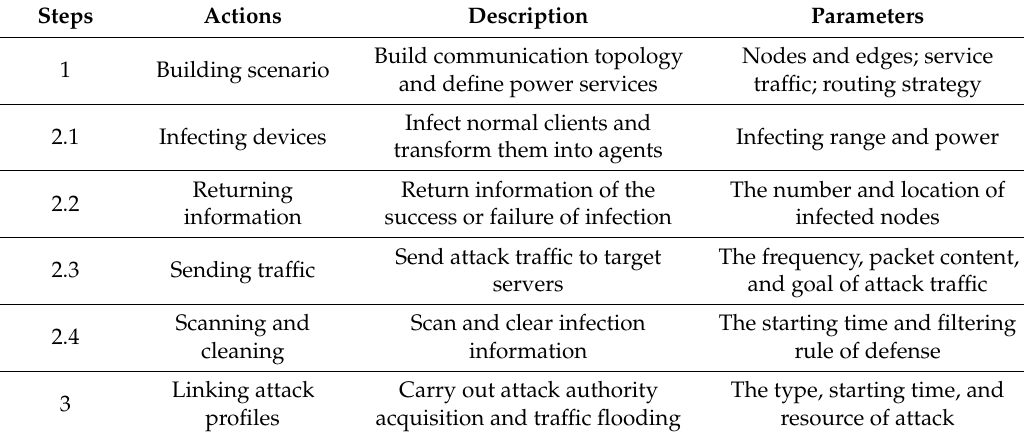
Table 1. Steps of the cyberattack